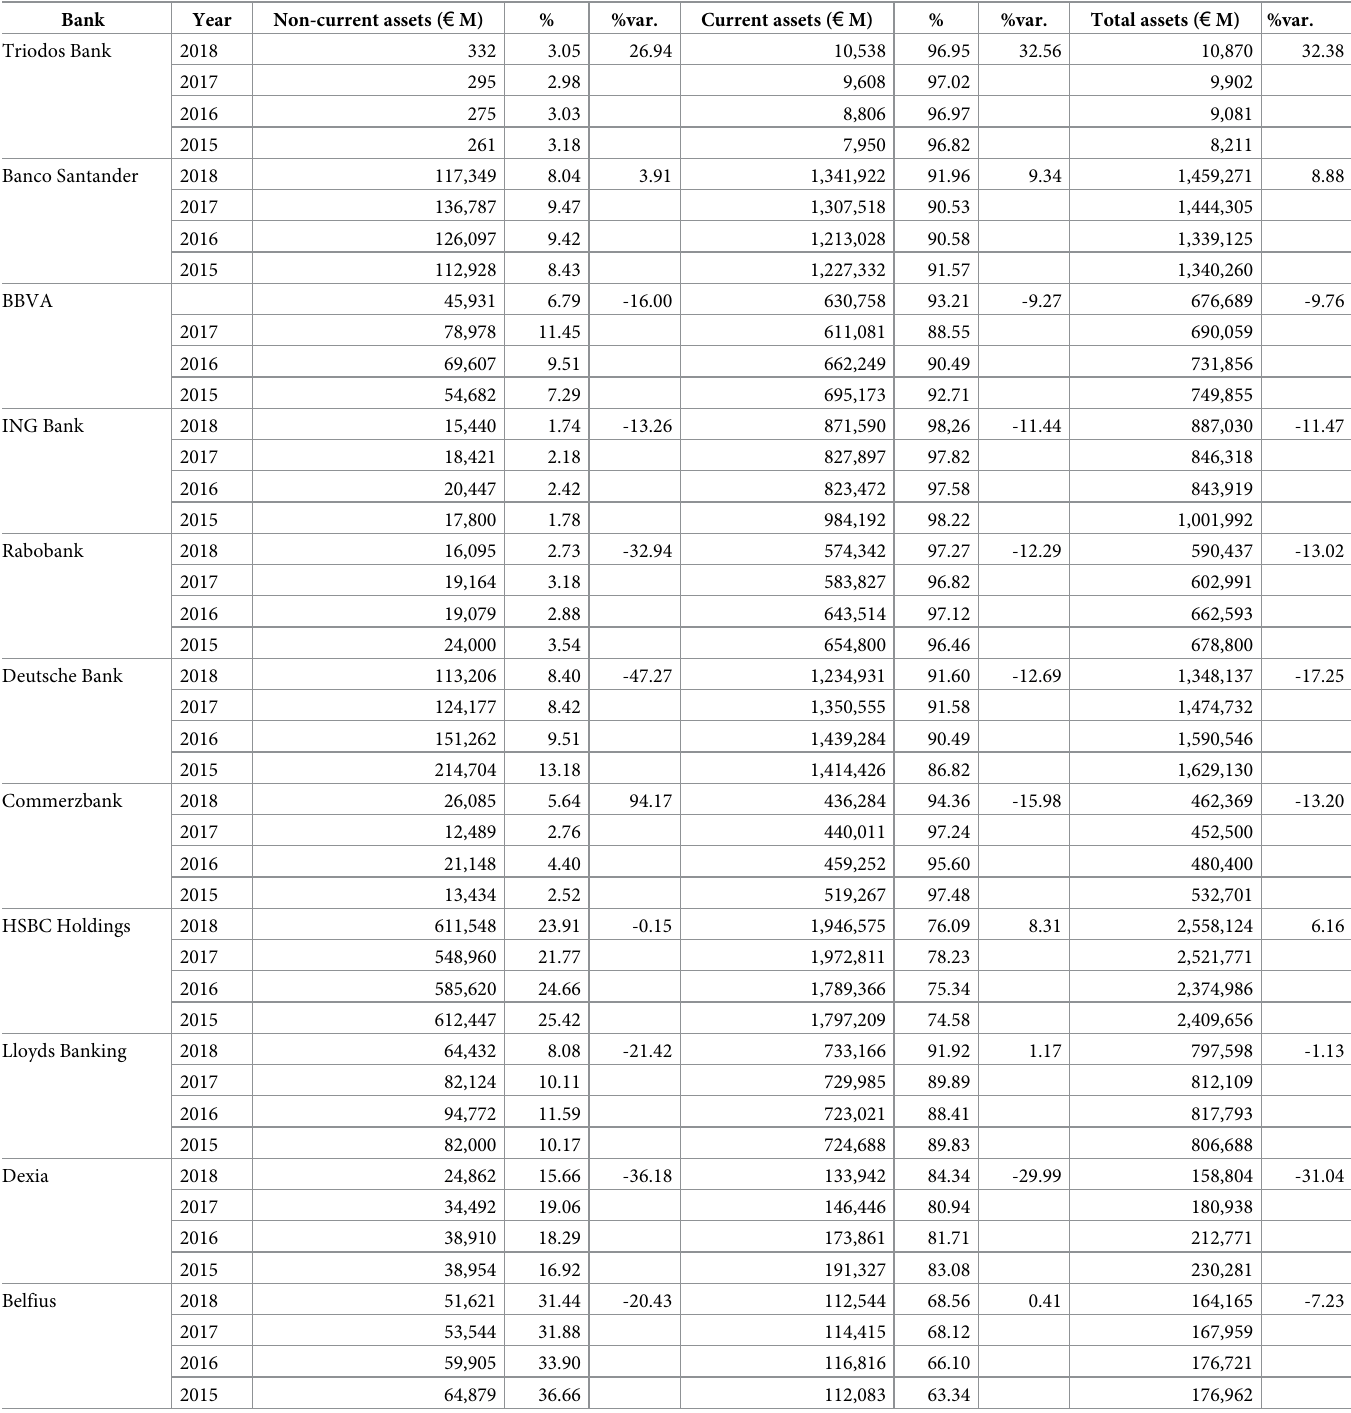
Table 4. Comparison of